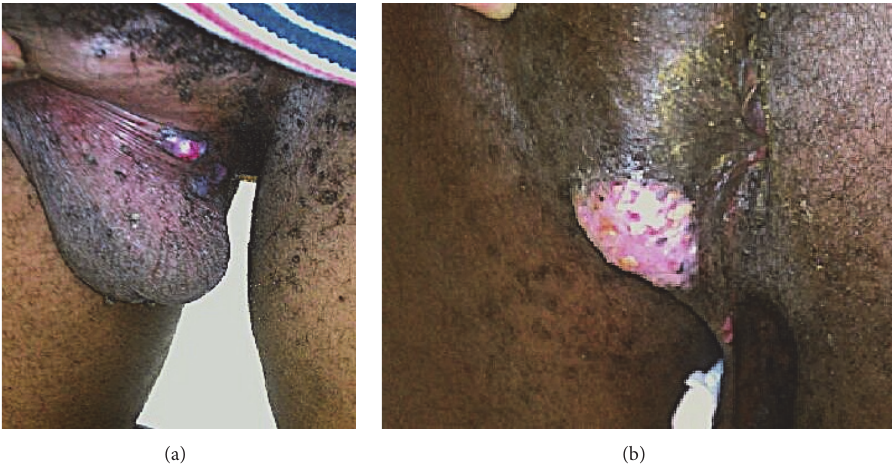
Figure 5: Appearance of pseudotumoral lesions on scrotum (a) and perineum (b) 11 days after starting